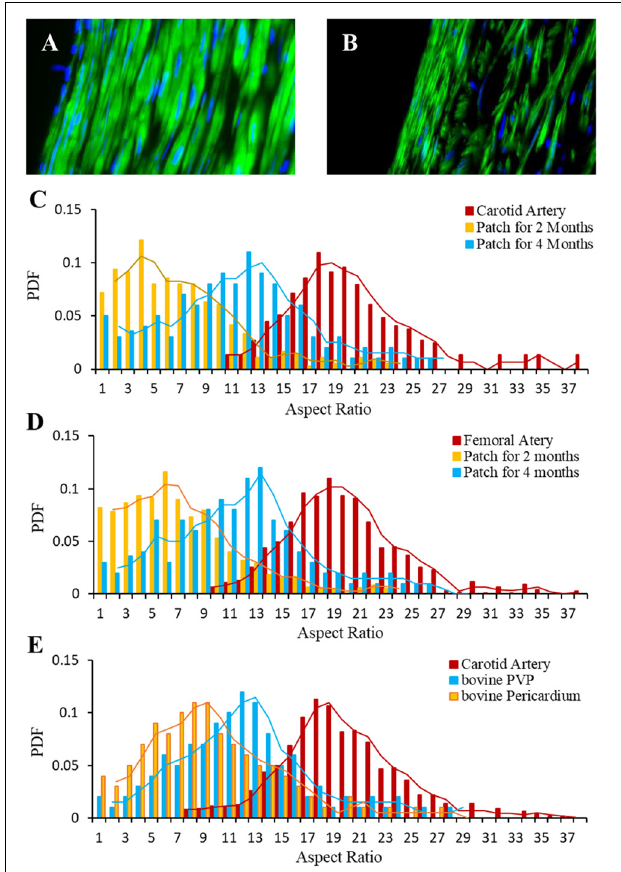
FIGURE 6 | Orientation of myofibroblasts in neo-media of patch-angioplasties. (A) Carotid media. (B) Neo-media of sPVP in 4-M Group. Green: anti-smooth muscle α -actin. Blue: nuclei. Objective: 60 × . (C) PDF vs. aspect ratios of the sPVP in carotid artery. (D) PDF vs. aspect ratios of the sPVP in femoral artery. (E) PDF vs. aspect ratios of the bPVP and pericardium in carotid artery in HF/4-M